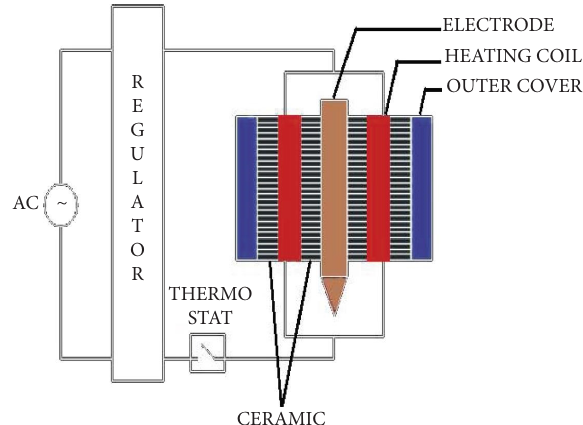
Figure 2: Designed heating unit for EMM Table 4. Higher MRRs reduced ROCs and reduced CFs are preferred in the EMM process.